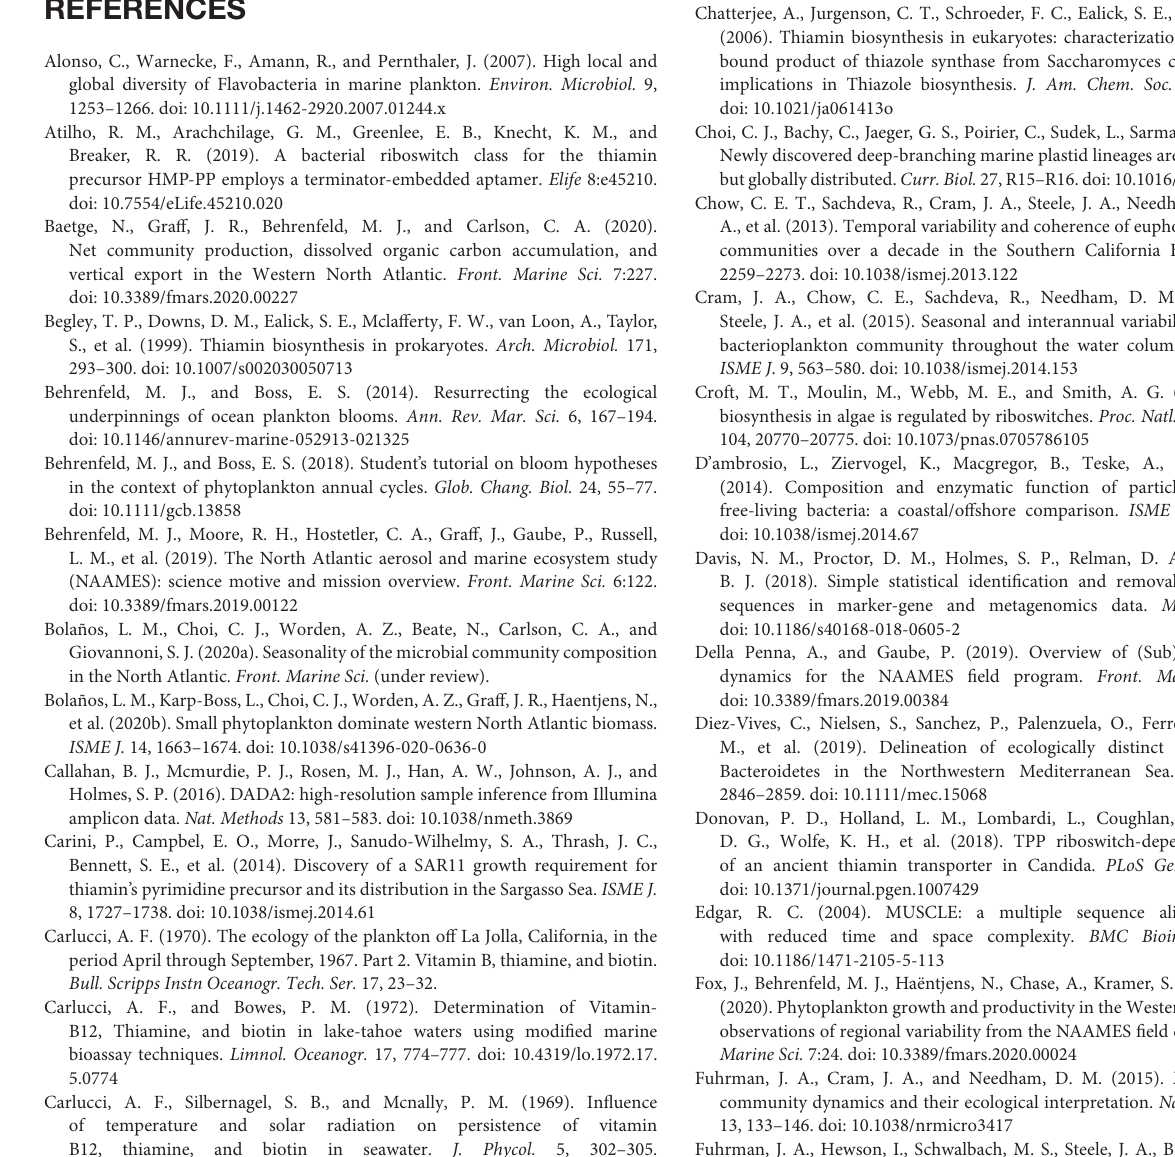
Supplementary Table 3 | Flavobacteria SAG Genome completeness. Supplementary Table 4 | Key enzymes for the de novo pathway to synthesize vitamin B1 determined to be present in Flavobacteria SAGs by HMMER